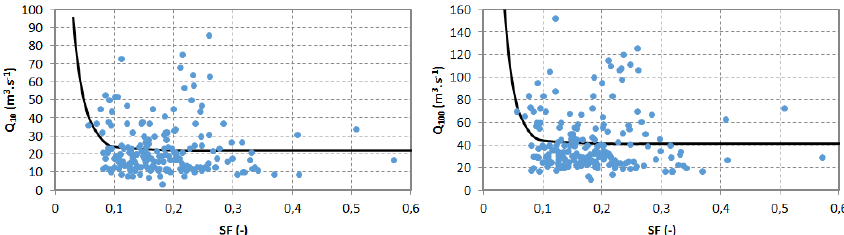
Figure 5. Relationship between catchment shape factor and peak discharge value for T = 10 years (left panel) and T = 100 years (right panel) with fitted lines following Eq.